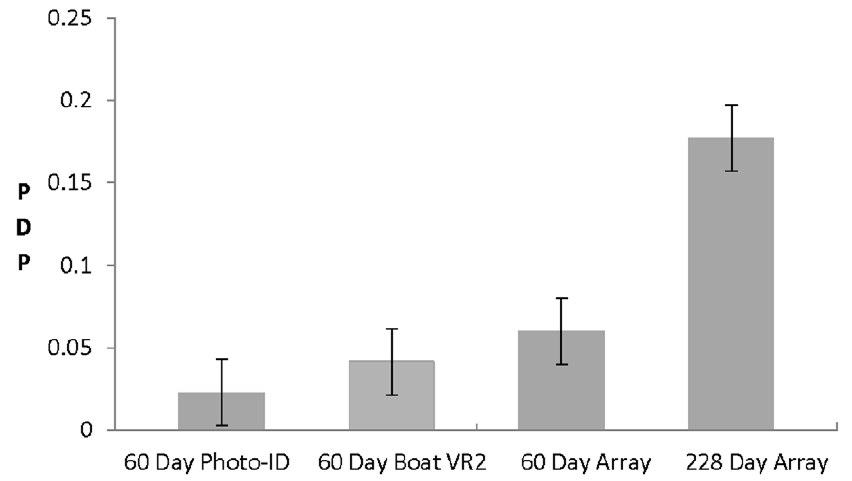
Figure 2. The proportion of days present (‘‘PDP’’) on average that each shark was confirmed to be in Mossel Bay as determined by each of the three sampling approaches (photo-ID, a VR2 acoustic listening station deployed from a boat, and an array of VR2 acoustic listening stations from 60 days of sampling, and the full array dataset for the entire 228 day study period) during the sampling period ( i.e. 3 rd April to 16 th November, 2005). Values are means 6 SE (n=22 replicates). doi:10.1371/journal.pone.0034753.g002 PLoS ONE |